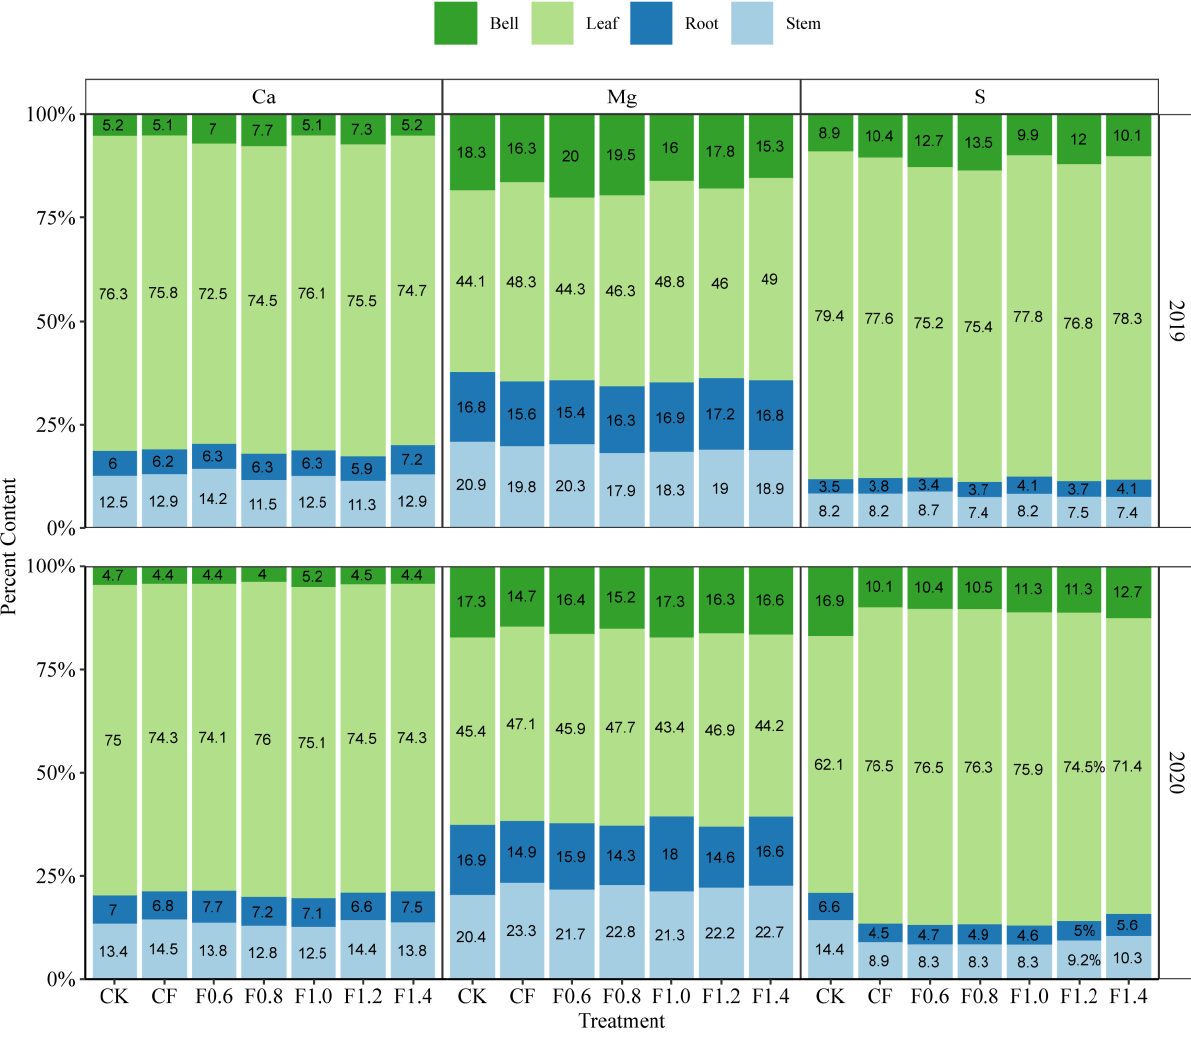
Figure 8. Changes in Ca, Mg and S distribution in cotton under different fertilization